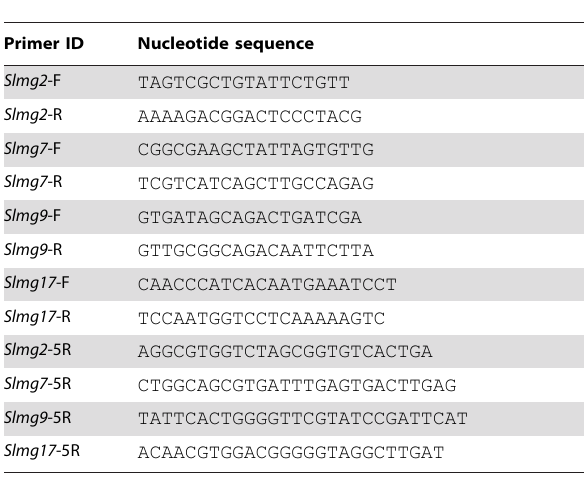
Table 1. Primer sequences used for cloning the cDNAs and